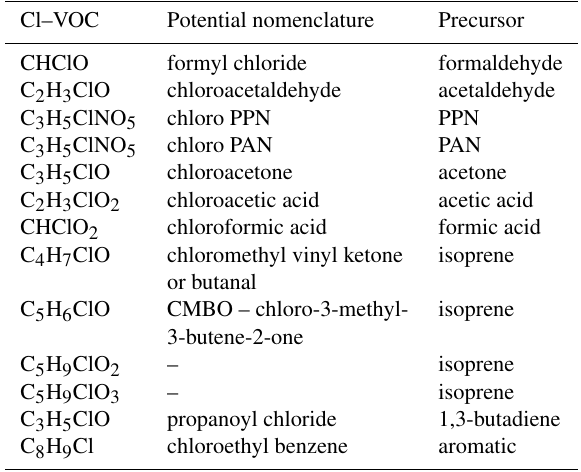
Table 1. Identified Cl–VOC reaction products, nomenclature of Cl– VOC and precursor